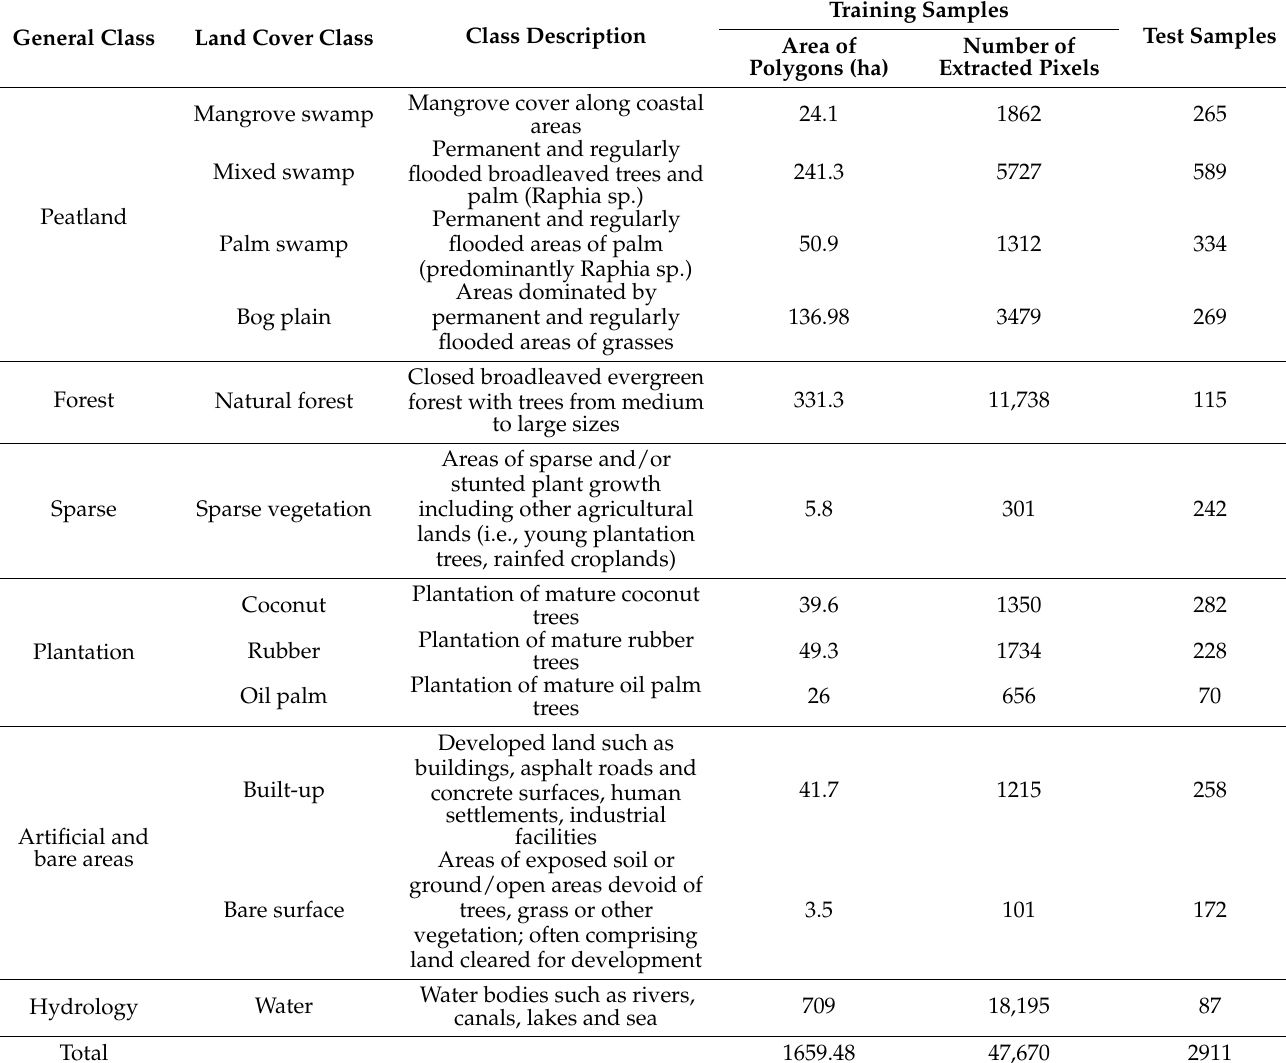
Table 2. Implemented land cover classes and the associated reference data. Training samples are expressed as total area of polygons and number of pixels extracted from these polygons, and test samples represent number of points. General